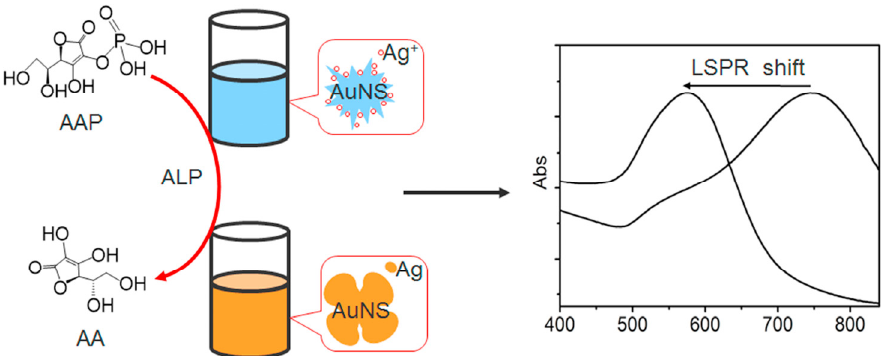
Figure 9. Scheme of the colorimetric sensor mechanism for ALP determination via enzyme-guided growth of AgNPs on AuNSs and the correspondent blue-shift of the LSPR peak. Reprinted with permission from [136], copyright 2015 Elsevier B.V.